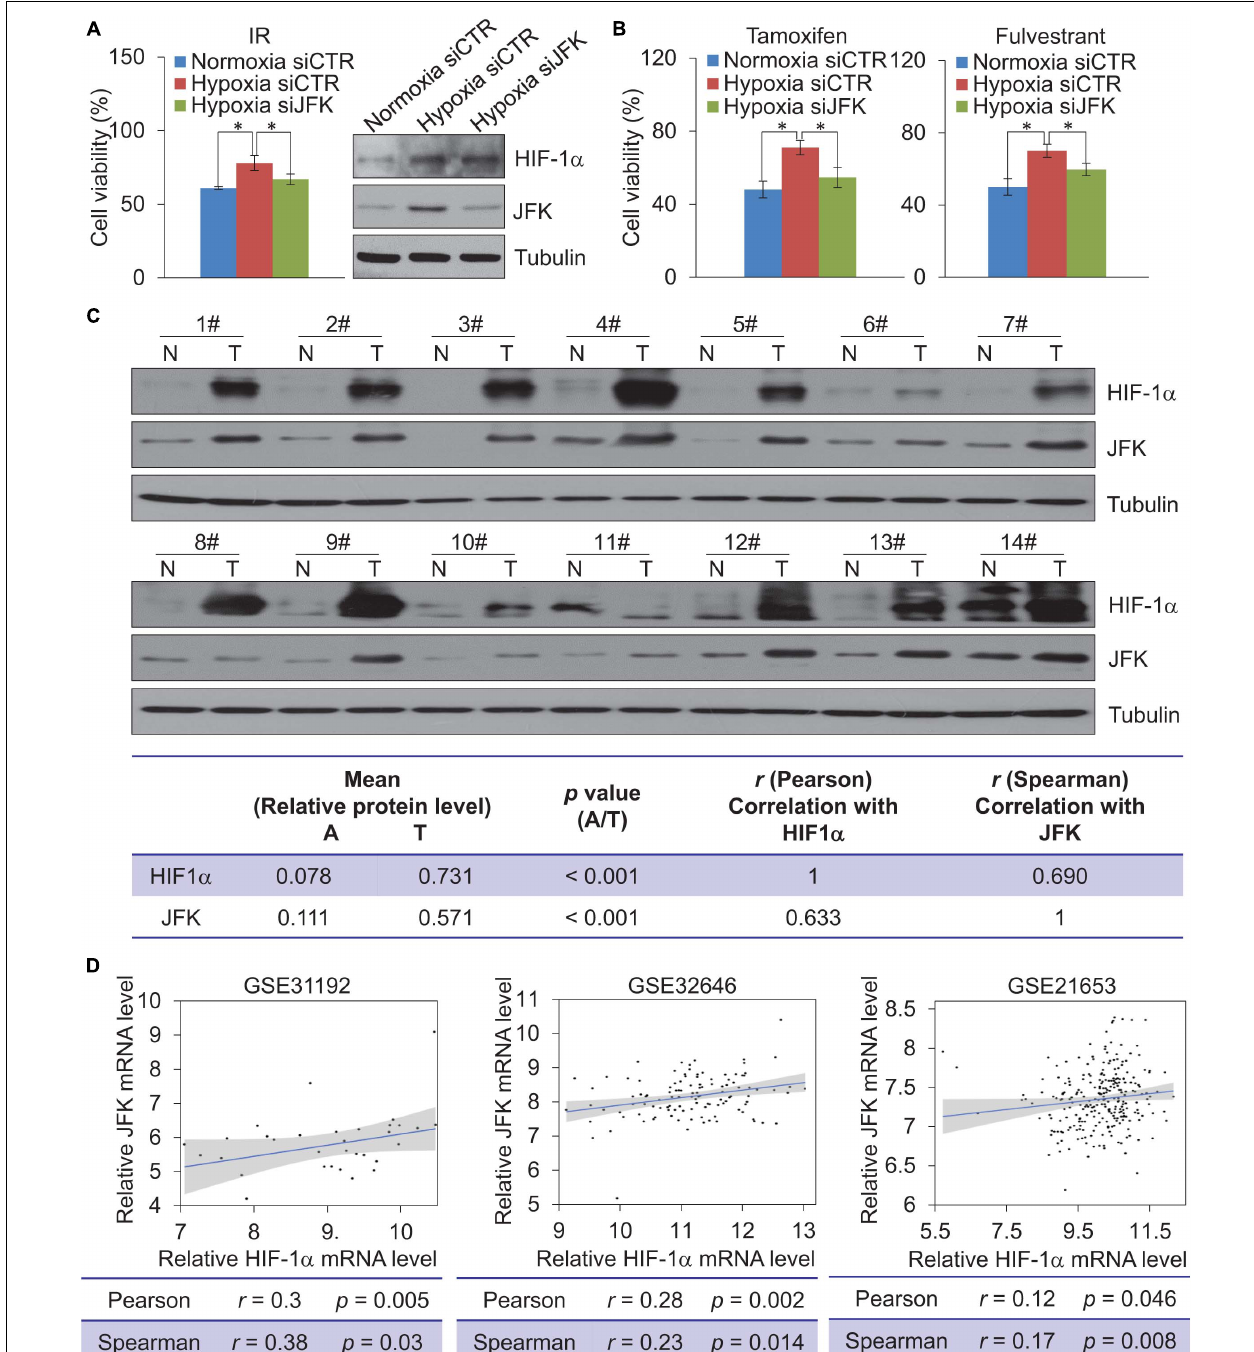
FIGURE 5 | JFK deficiency sensitizes hypoxic breast cancer cells to chemo-radiotherapeutic treatment. (A) MCF-7 cells treated with control or JFK siRNAs were cultured in normoxia or hypoxia (1% O 2 ) conditions, and treated with IR (5 Gy) and subjected to cell viability assessment. Error bars represent the mean ± SD for triplicate experiments. Cellular extracts were prepared for western blotting analysis with the indicated antibodies. (B) MCF-7 cells treated with control or JFK siRNAs were cultured in normoxia or hypoxia (1% O 2 ) conditions, and treated with tamoxifen (0.5 µ M) or fulvestrant (0.5 µ M) and subjected to cell viability assessment. Error bars represent the mean ± SD for triplicate experiments. (C) Western blotting analysis in 14 breast tumors (T) paired with adjacent normal tissues (N) from breast carcinoma patients for the expression of HIF-1 α and JFK. Quantitation was performed based on densitometry using Image J, and the values are expressed after normalization to the level of tubulin. The results from correlation analysis between HIF-1 α and JFK expression are shown. (D) The level of JFK mRNA expression was plotted against the level of HIF-1 α mRNA expression in published clinical datasets (GSE31992, GSE32646, and GSE21653); the line presents a fitted linear model, and the shading represents the 95% confidence interval. Statistical significance of differences is indicated as * p < 0.05.